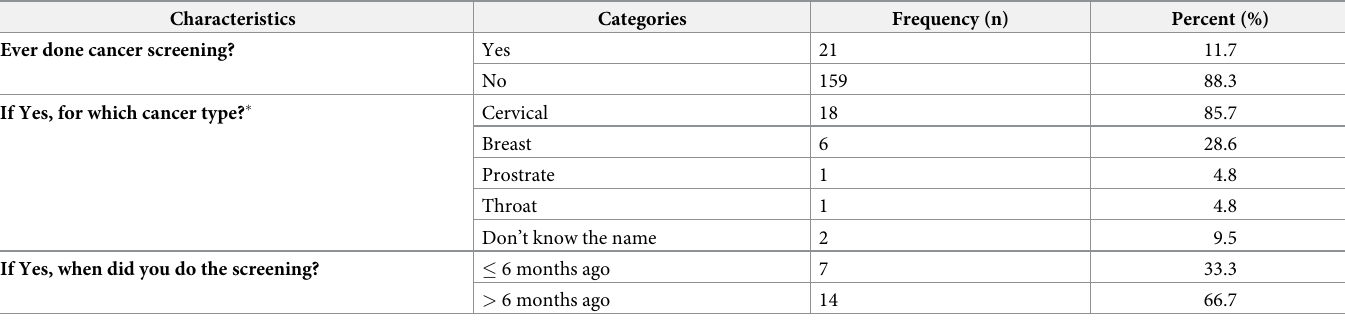
Table 4. Cancer screening behaviour among the study participants (n =